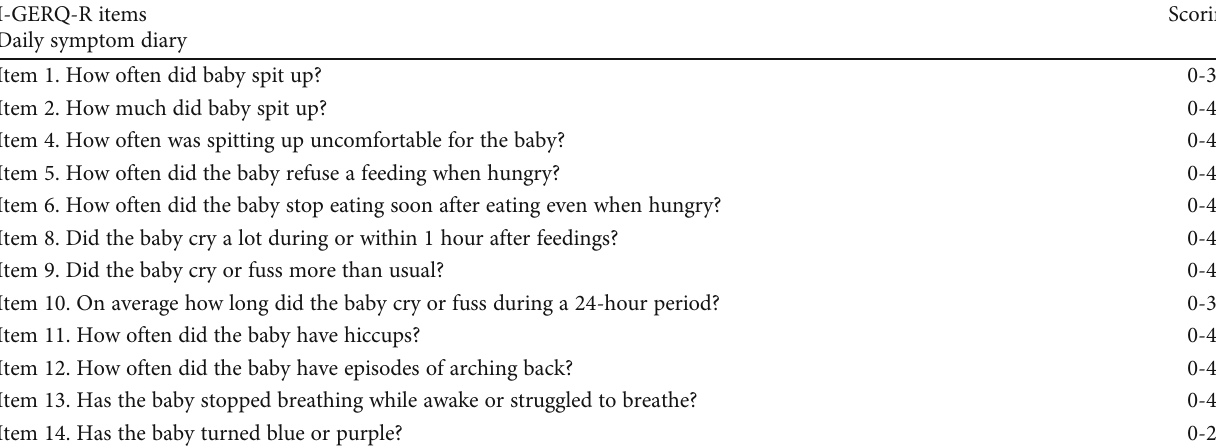
Table 1: Correlations between daily symptom diary and the